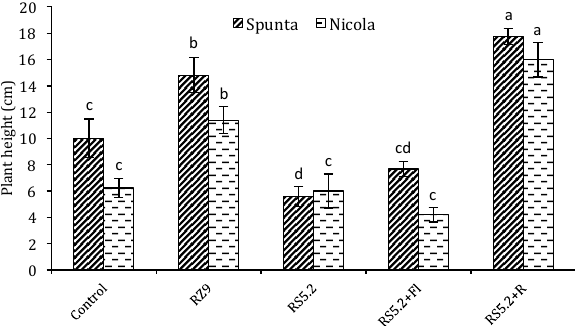
Figure 3. Mean heights of plants of the potato cvs ′Spunta′ and ′Nicola′ at 30 d post-plantating in the biocontrol assay of Rhizoctonia solani under greenhouse conditions. For each cultivar, values with different letters are statistically differ - ent (Fishers LSD test; P < 0.05). Bars represented standard errors. RZ9: P. aeruginosa ; RS5.2: R. solani ; fludioxonil: fun - gicide chemical.